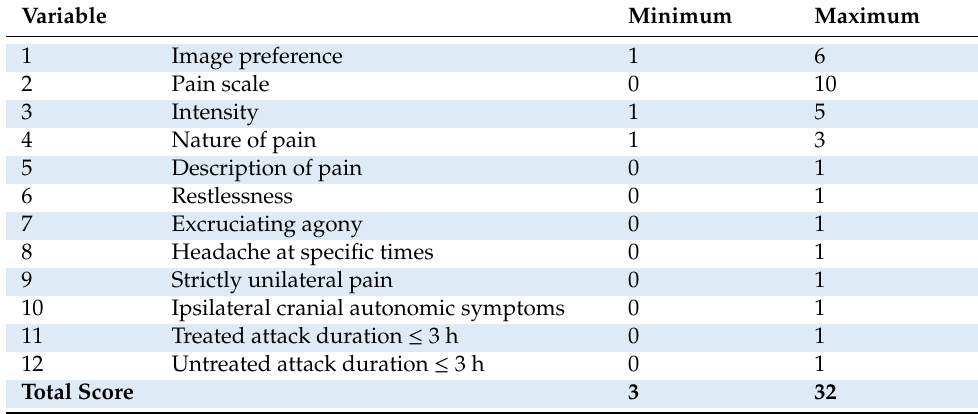
Table 2. Computation of the total